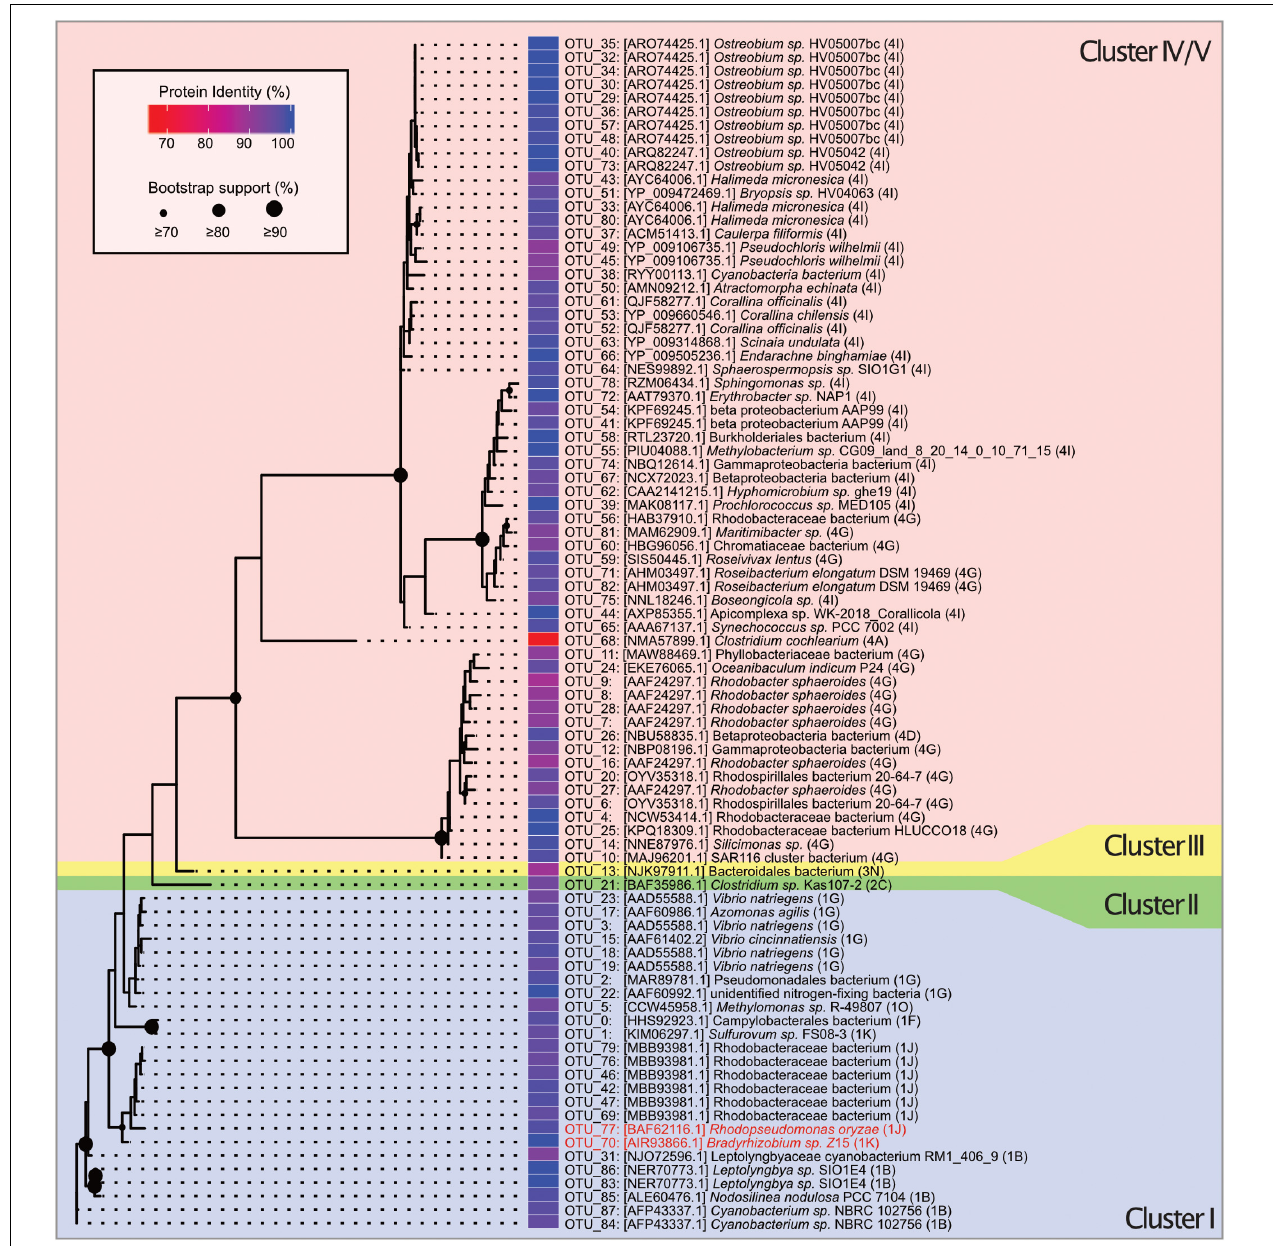
FIGURE 2 | Unrooted maximum likelihood tree of 88 OTUs belonging to nifH gene clusters I–V constructed from 200 ML starting trees. The nifH cluster identities follow the classification and regression tree model shown in parentheses and with different background colors. Names and sequence IDs are best hits from BLASTP searches against NCBI’s non-redundant protein database. Colored cells show percent identity of the closest protein match to the OTU representative sequence. Circles on nodes indicate bootstrap support (1,000 bootstraps). Taxa identified as putative contaminants due to their presence in the negative extraction are marked in red